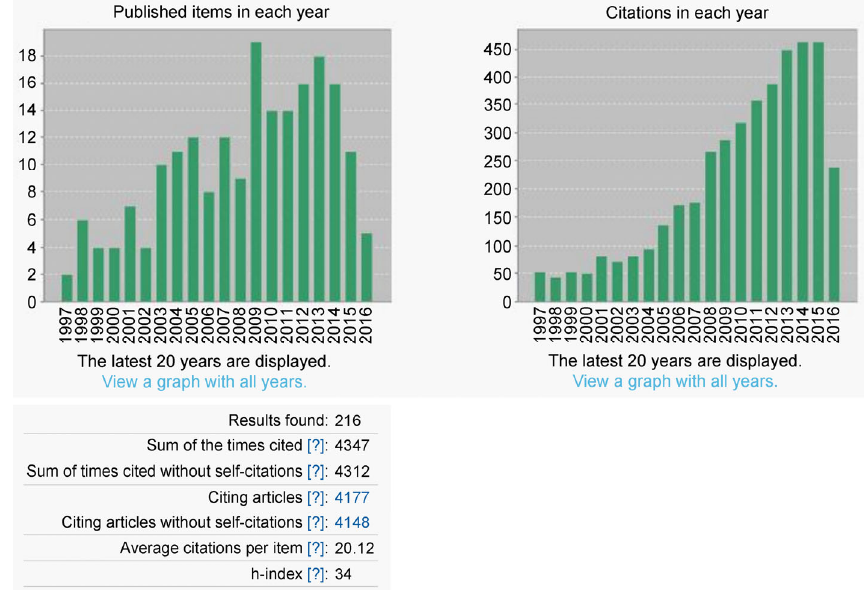
Fig. 3 Articles published in the domain containing keywords of friction models, static and